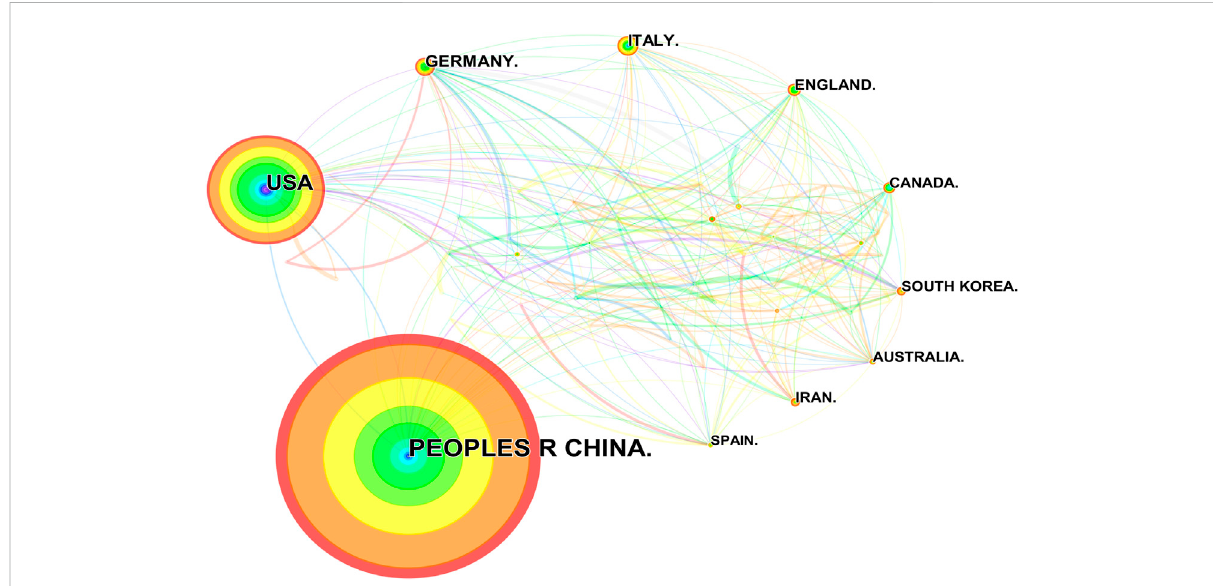
FIGURE 3 Publications over countries. The node size represents the number of articles. The larger the node, the greater the number of articles published bythecountry.The fi gureshowsthetop20countriesintermsofnumberofpublishedarticles.Chinaranks fi rst,andtheothercountries,inclockwise order, are the United States, Germany, Italy, England, Canada, South Korea, Australia, Iran, and Spain. The lines between the nodes represent the cooperation between the different countries.